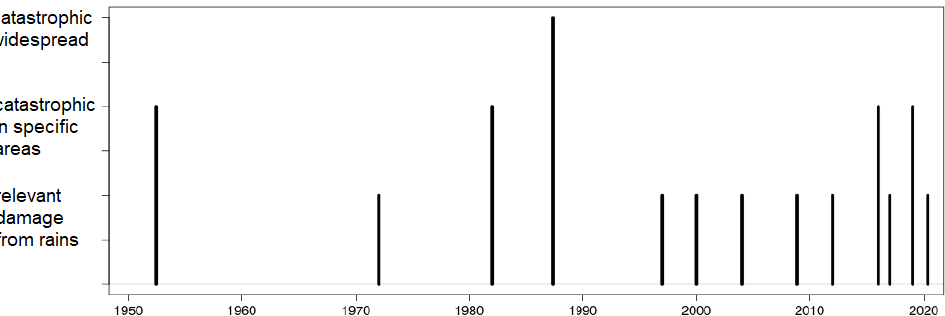
Figure 1. Impact level of flooding events between 1950 and 2020 in the Campo de Cartagena basin. Source: AEMET and Consorcio de Compensación de seguros de España [22,23].